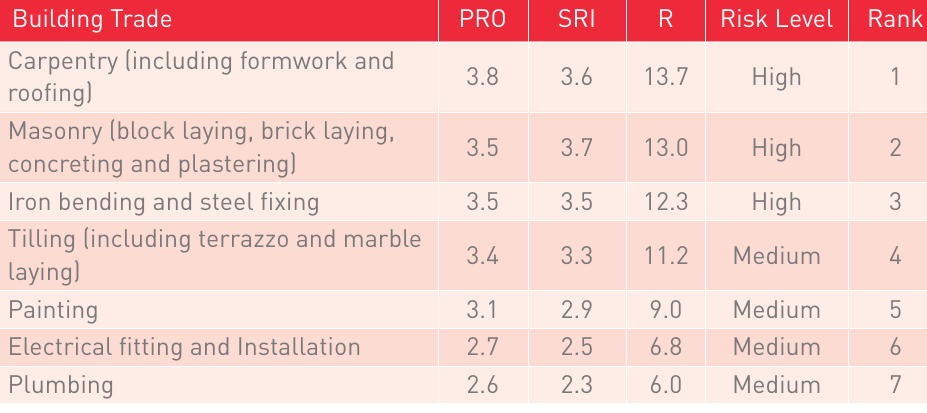
Summary of the result of risk analysis on common building trades Building